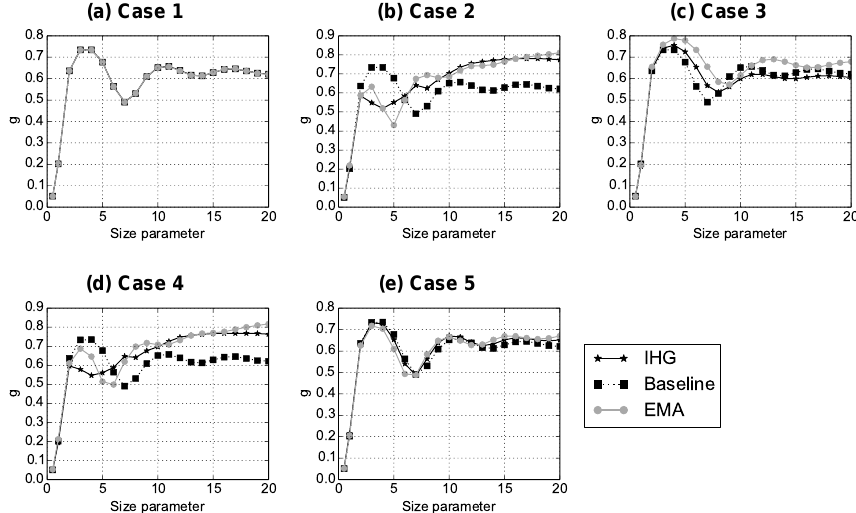
Figure 11. Asymmetry parameter for the inhomogeneous (IHG), the baseline, and the homogeneous (EMA) versions of all five particle cases as a function of the size parameter of the particle.